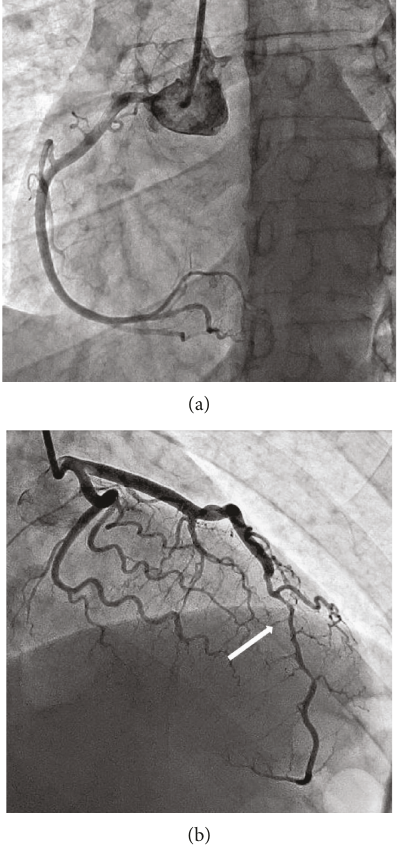
Figure 2: The fi rst coronary angiography revealed a long segment disease of the LAD artery. Right coronary artery is normal.